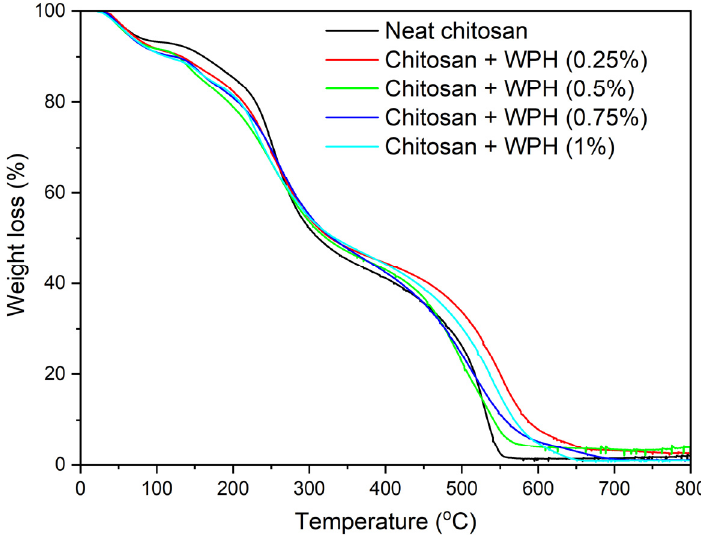
Figure 8. TGA analysis of chitosan/WPH films containing different concentrations of WPH showing loss in mass with increasing annealing temperature.